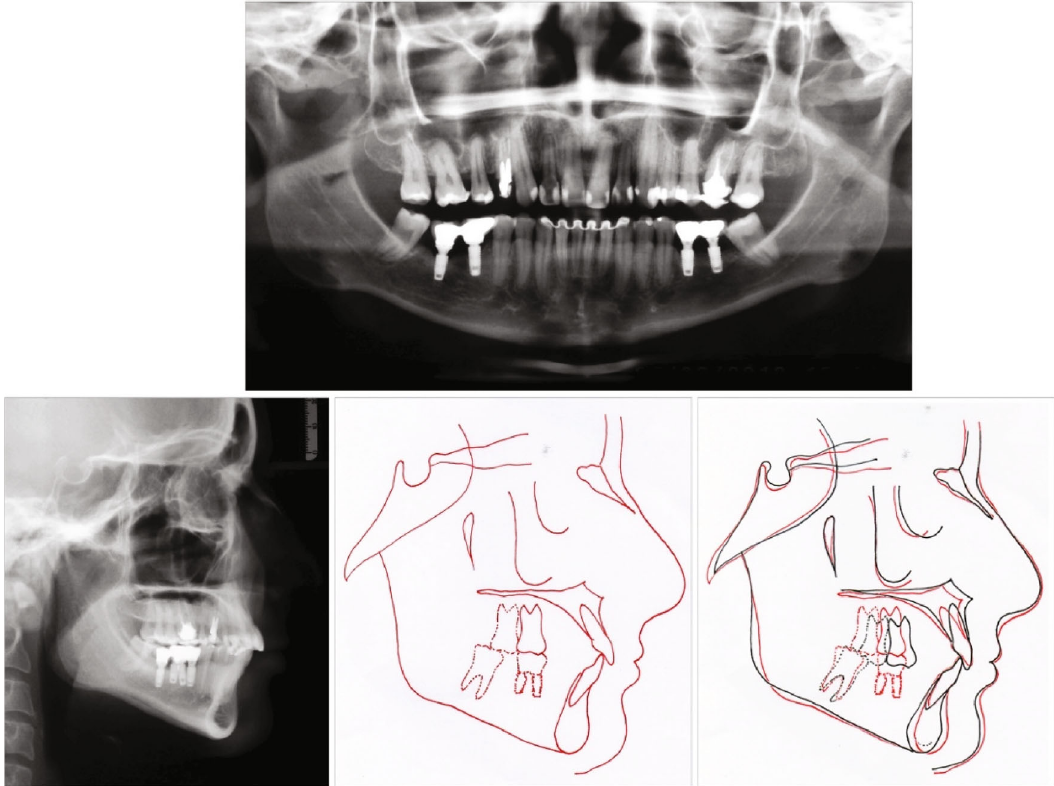
Figure 9: Posttreatment panoramic radiograph, lateral radiograph, lateral cephalometric radiograph tracing, and superimposition: before treatment (black) and after treatment (red).